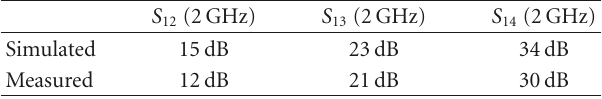
Figure 3: Measured E- and H-plane normalized radiation patterns at two resonant frequencies of 1.92 GHz and 2.15GHz. Table 2: Interelement coupling for each element of 4 × 1